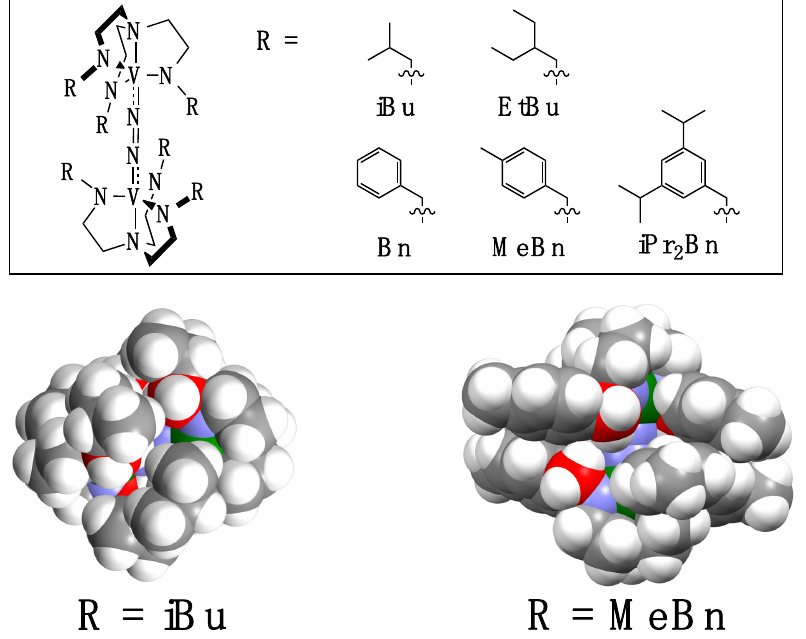
Figure 1. The structures of our previously reported divanadium–dinitrogen complexes [[{V( L R )} 2 ( µ - N 2 )] ( top ) and space-filling models of two dinitrogen complexes [{V( L R )} 2 ( µ -N 2 )] (R = iBu and MeBn) ( bottom ). The hydrogen, nitrogen, and vanadium atoms are shown in white, blue, and green, respectively. Secondary carbon atoms on the terminal N atoms are red, and the other carbon atoms are